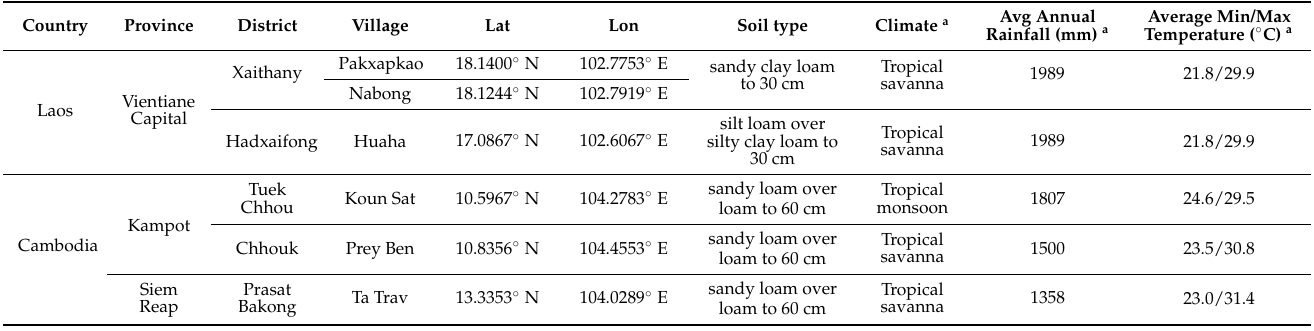
Table 1. Location, soil, and climate of irrigation trial field sites in Laos and